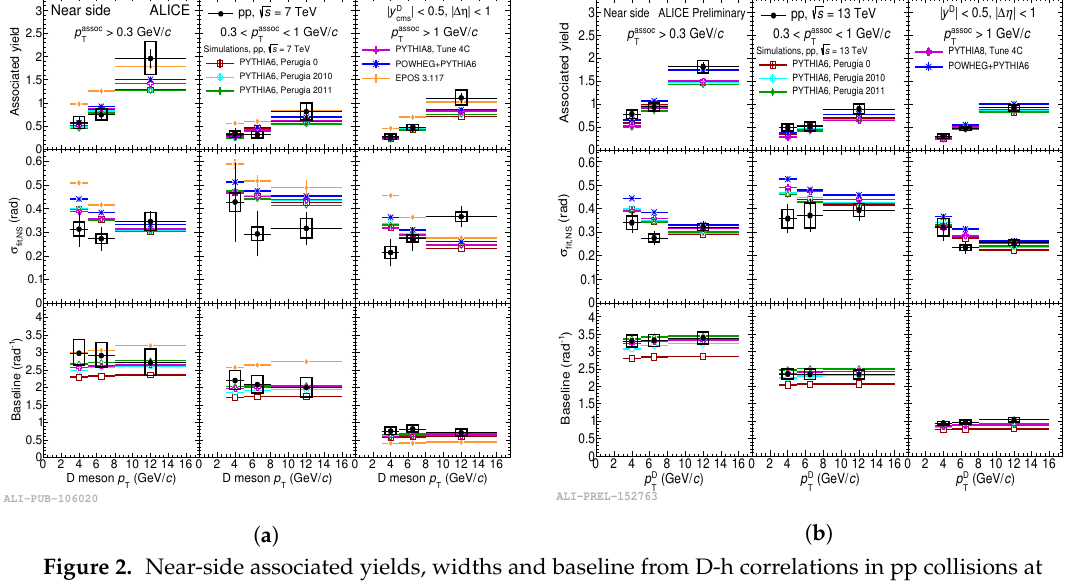
Figure 2. Near-side associated yields, widths and baseline from D-h correlations in pp collisions at √ √ s = 7 TeV and ( b ) s = 13 TeV compared with PYTHIA6, PYTHIA8, POWHEG+PYTHIA6 and ( a ) EPOS3 predictions.